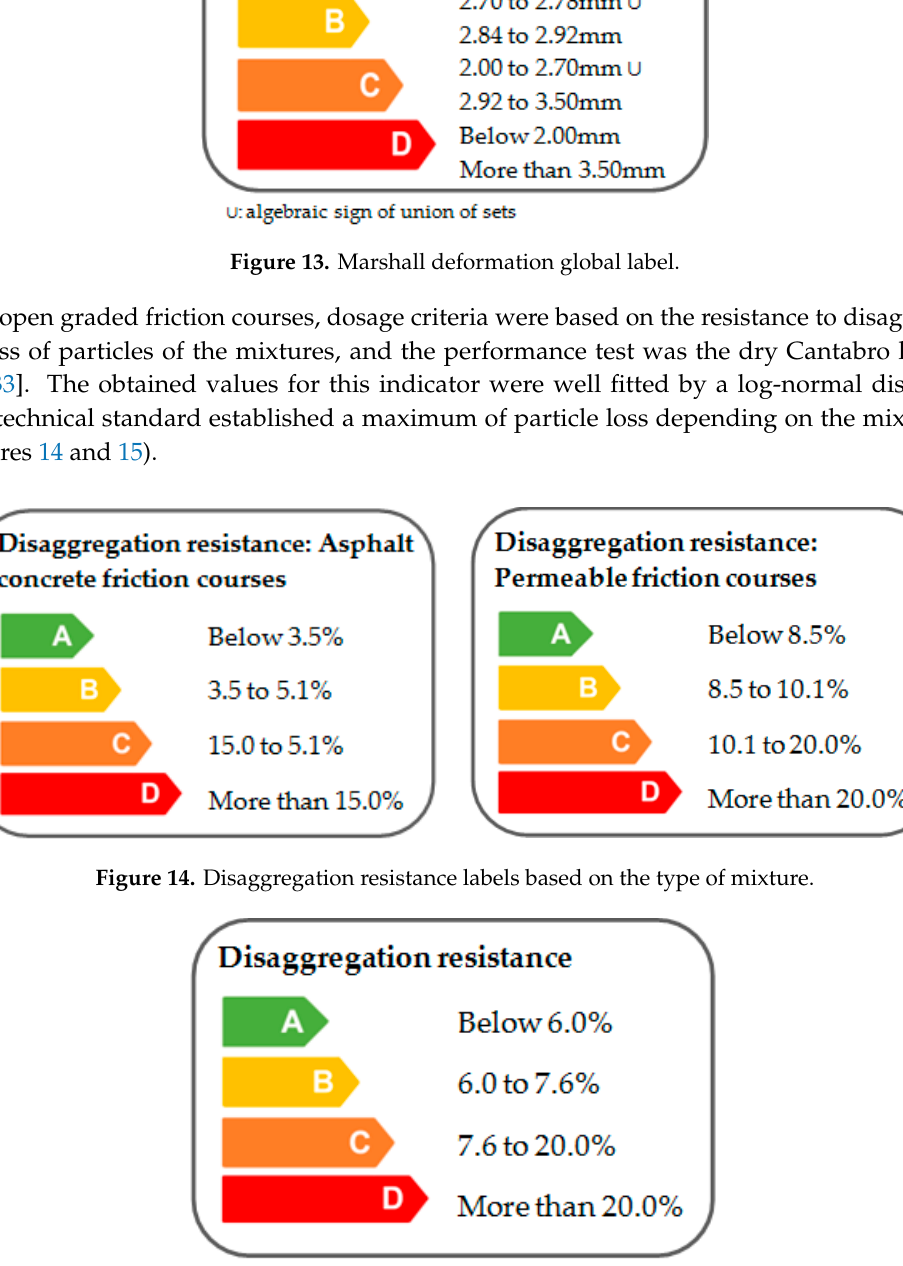
Figure 12. Marshall stability global label.